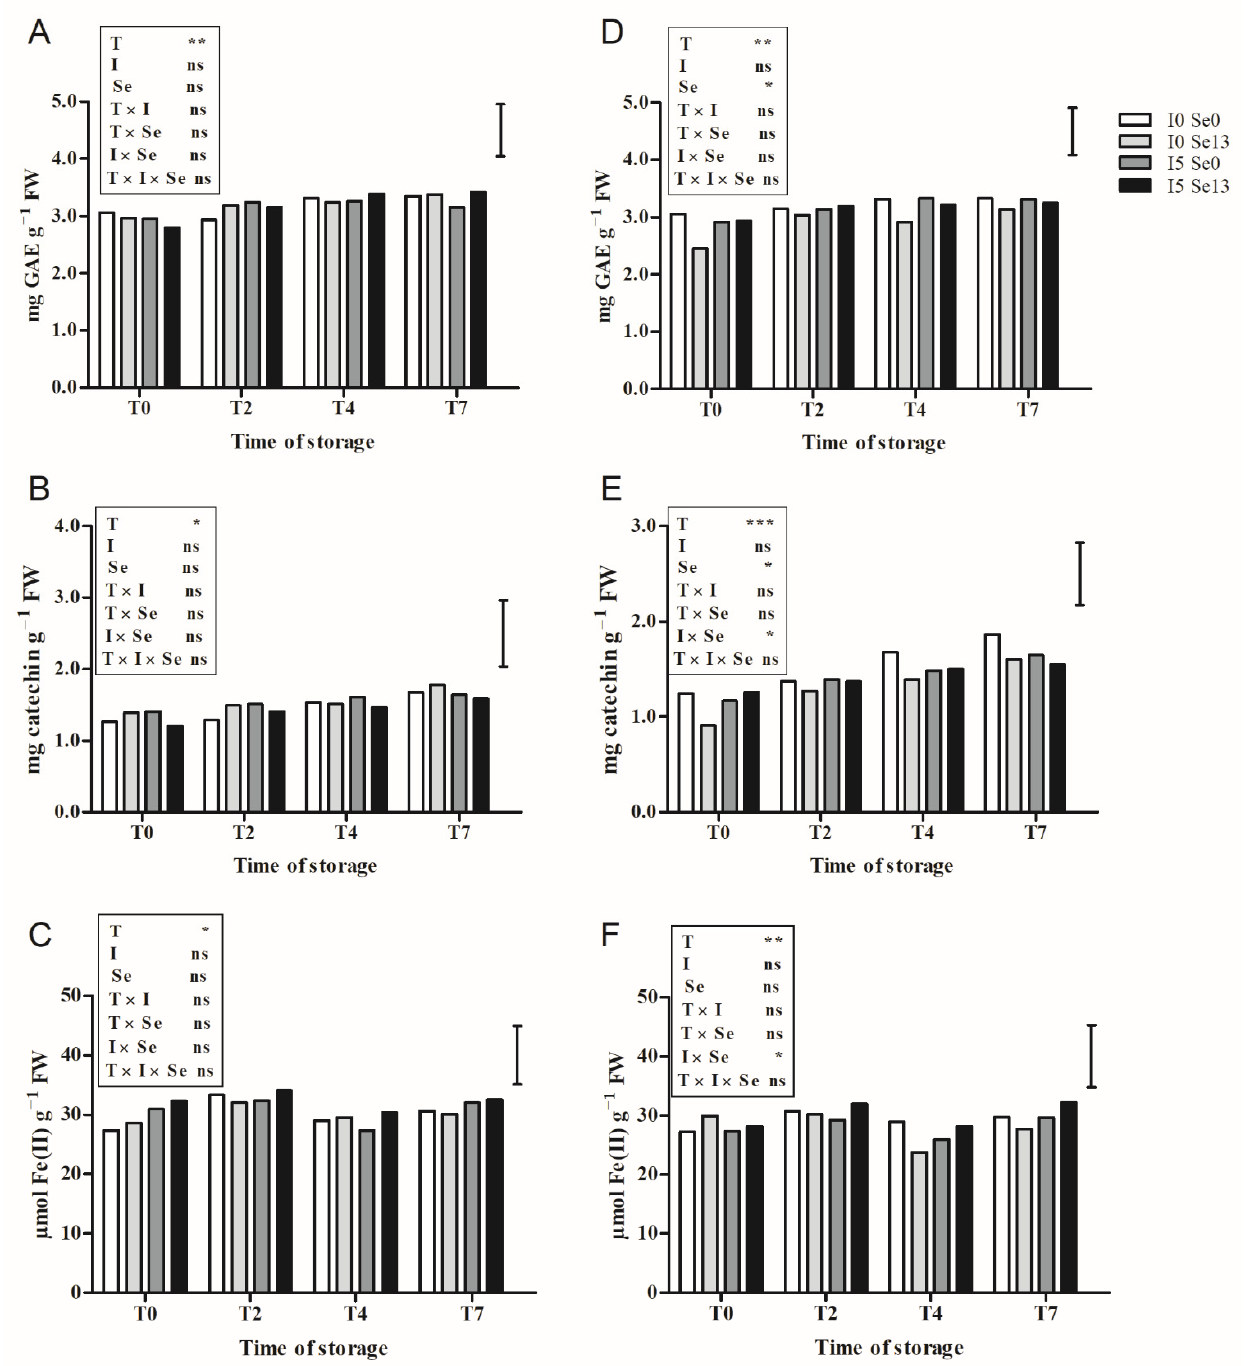
Figure 2. Total phenol, FS ( A ) and AE ( D ), and flavonoid, FS ( B ) and AE ( E ), content, and antioxidant capacity, FS ( C ) and AE ( F ), measured after 2 (T2), 4 (T4), and 7 (T7) days of storage in leaves of lettuce plants grown at different concentrations of I (0 and 5 µM) and Se (0 and 13 µM) in the nutrient solution, in the second experiment. Values are means of the 3 replicates. Significance level: *** p ≤ 0.001; ** p ≤ 0.01; * p ≤ 0.05; ns = not significant. Bar indicates LSD value.